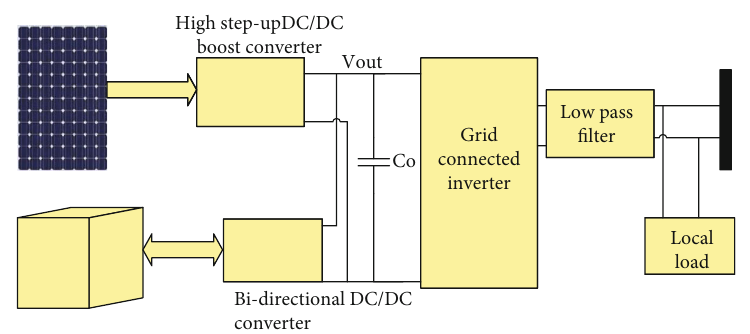
Figure 1: Drawing of the single-phase PV grid-connected power system.